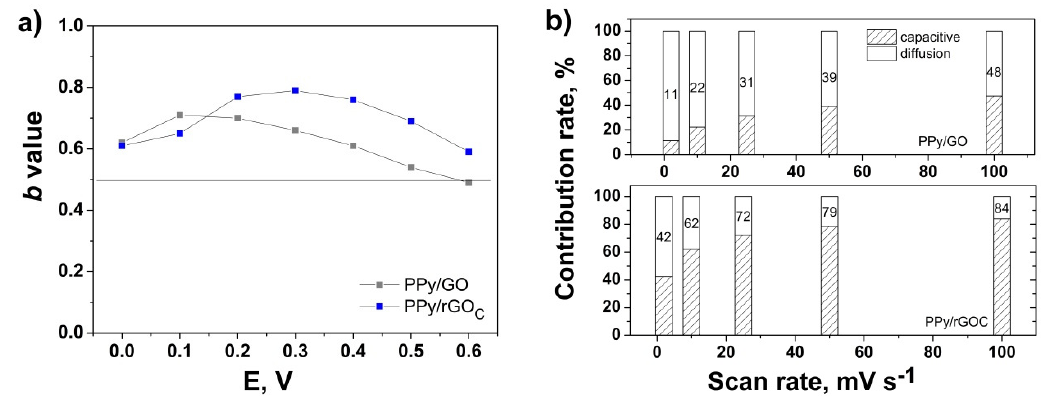
Figure 8. Evolution of the b value with the potential ( a ) and contributions to the current response with the scan rate ( b ) for PPy electrodeposited onto GO and rGO C .